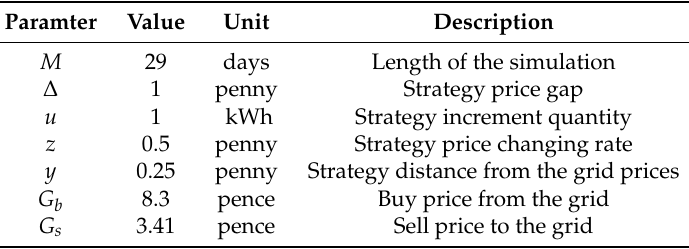
Table 1. Simulations fixed